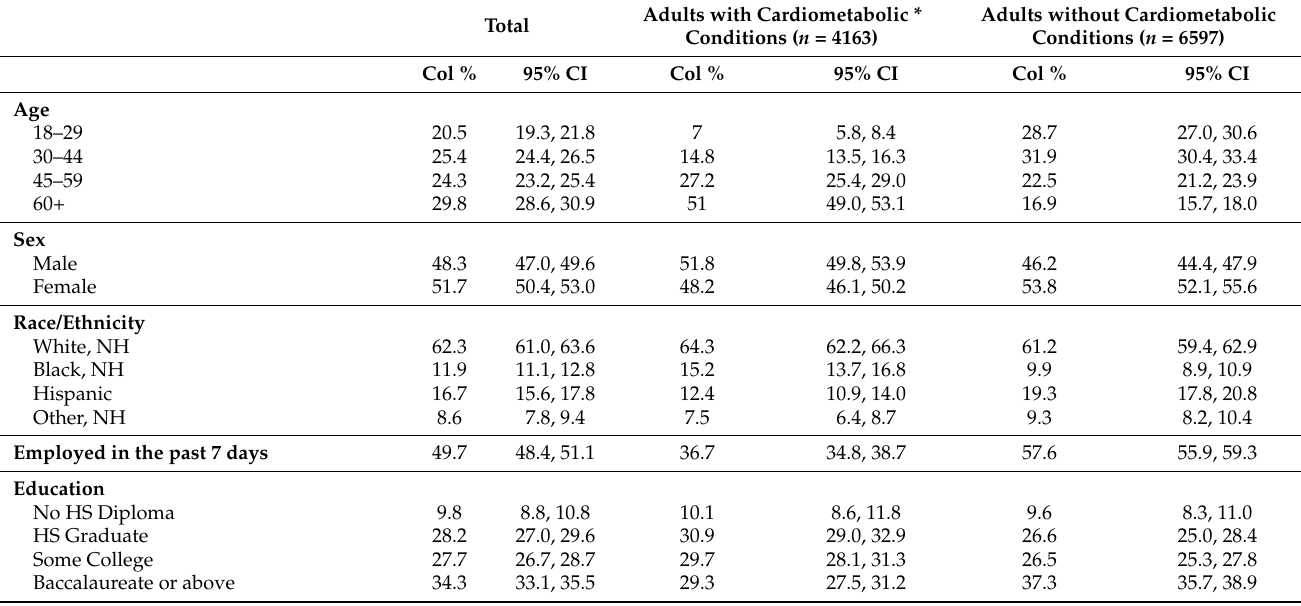
Table 1. Characteristics of COVID Impact Survey respondents ( n = 10,760), a nationally representative survey of the US, stratified by cardiometabolic disease status (April–June 2020). Adults with Cardiometabolic * Adults without Cardiometabolic Total Conditions ( n = 4163) Conditions ( n =